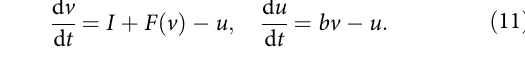
Fig. 2b: it reaches in fi nity at t * = 1 and subsequently crosses at two points that move apart as dictated by the motion of the parabola. In Fig. 2c, d are shown solutions u ( x , t ) of Eq. (12) around their crossing of the 1 level, and the corresponding w ( x , t ) = 1/( u ( x , t ) − 1) (solutions of Eq. (13)). Figure 2c corresponds to the solutions just before crossing, and Fig. 2d to solutions just after crossing in fi nity.